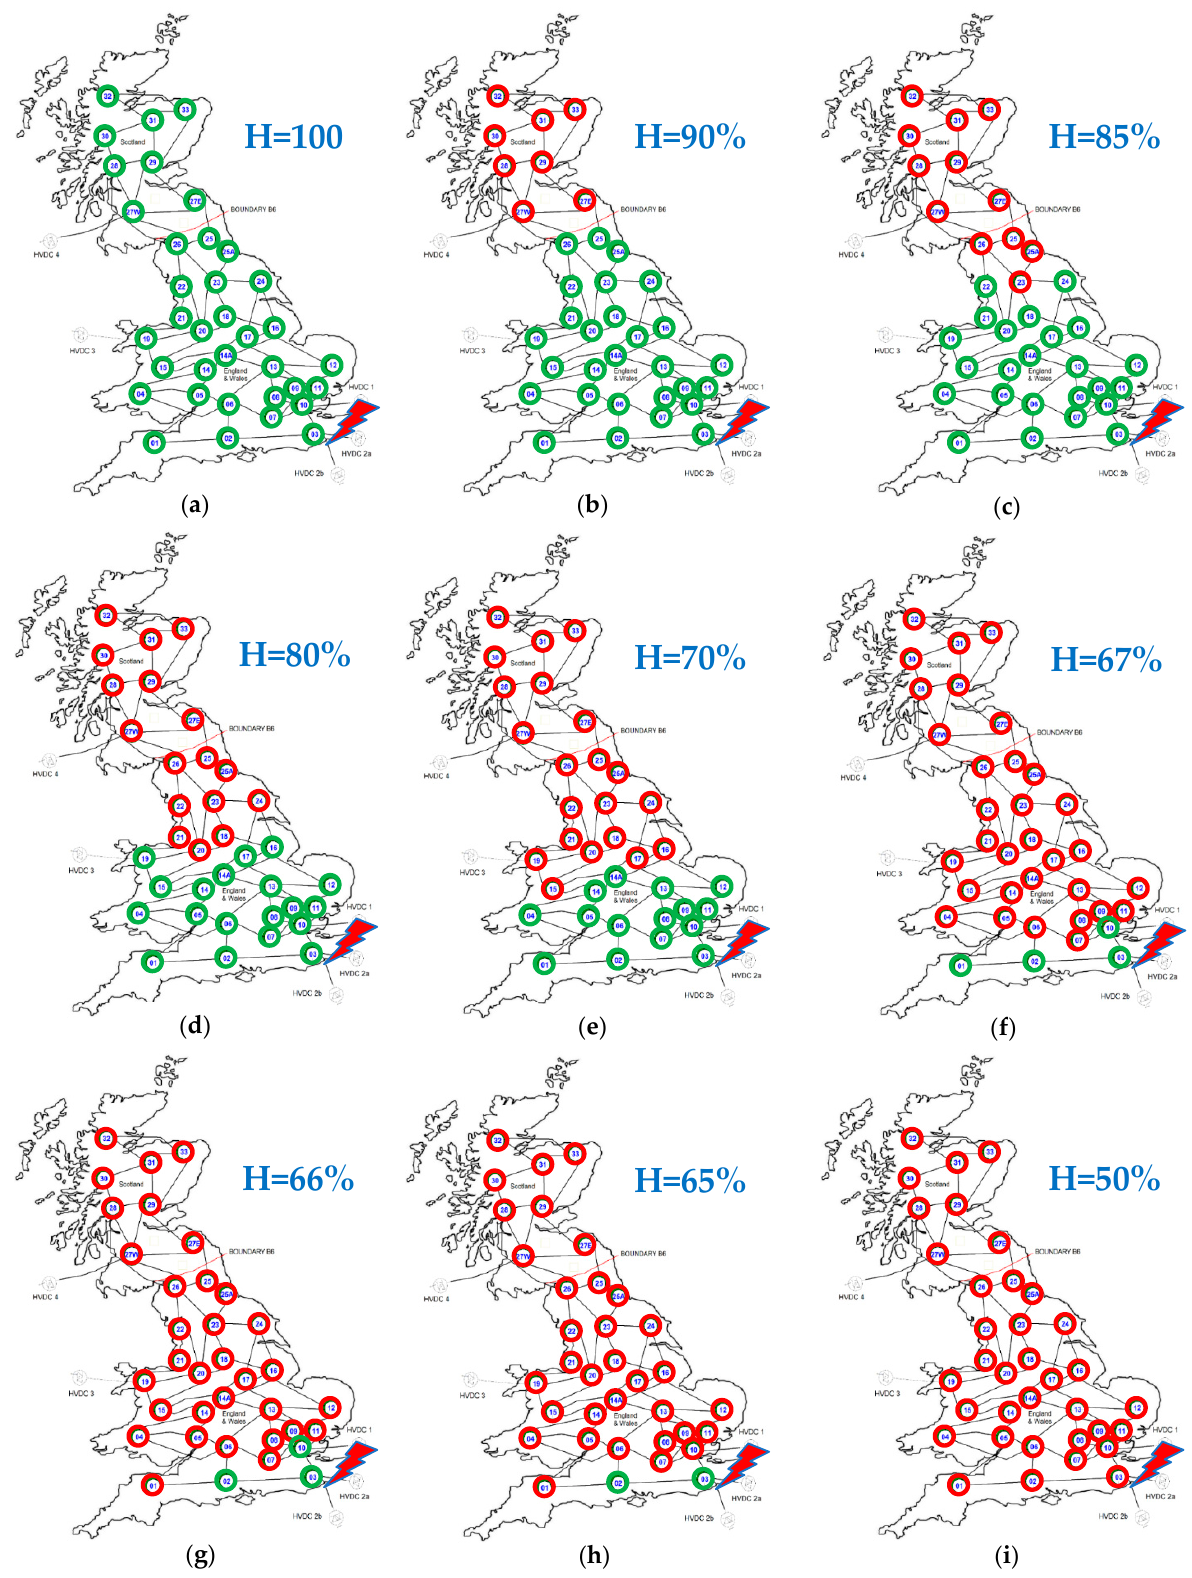
Figure 17. The geographical evolution of the RoCoF relay tripping as system inertia is reduced. Results are based on a PowerFactory simulation of a 1000 MW infeed loss in the Southeast corner and inertia from 100% to 50%. Red = relay trip, green = no trip.